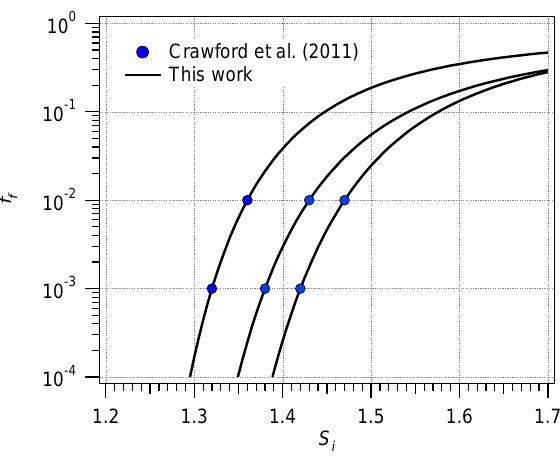
Fig. 9. Parameterization of the heterogeneous ice nucleation spectra for deposition ice nucleation on “generic dust” (DUST) and soot with low organic carbon content (SOOT) (Table 4). The shaded area corresponds to T = [200–250] K, u = [ 0 . 01 − 1 ] m s − 1 , and 40 ¯ s p = [0.1–100] µm 2